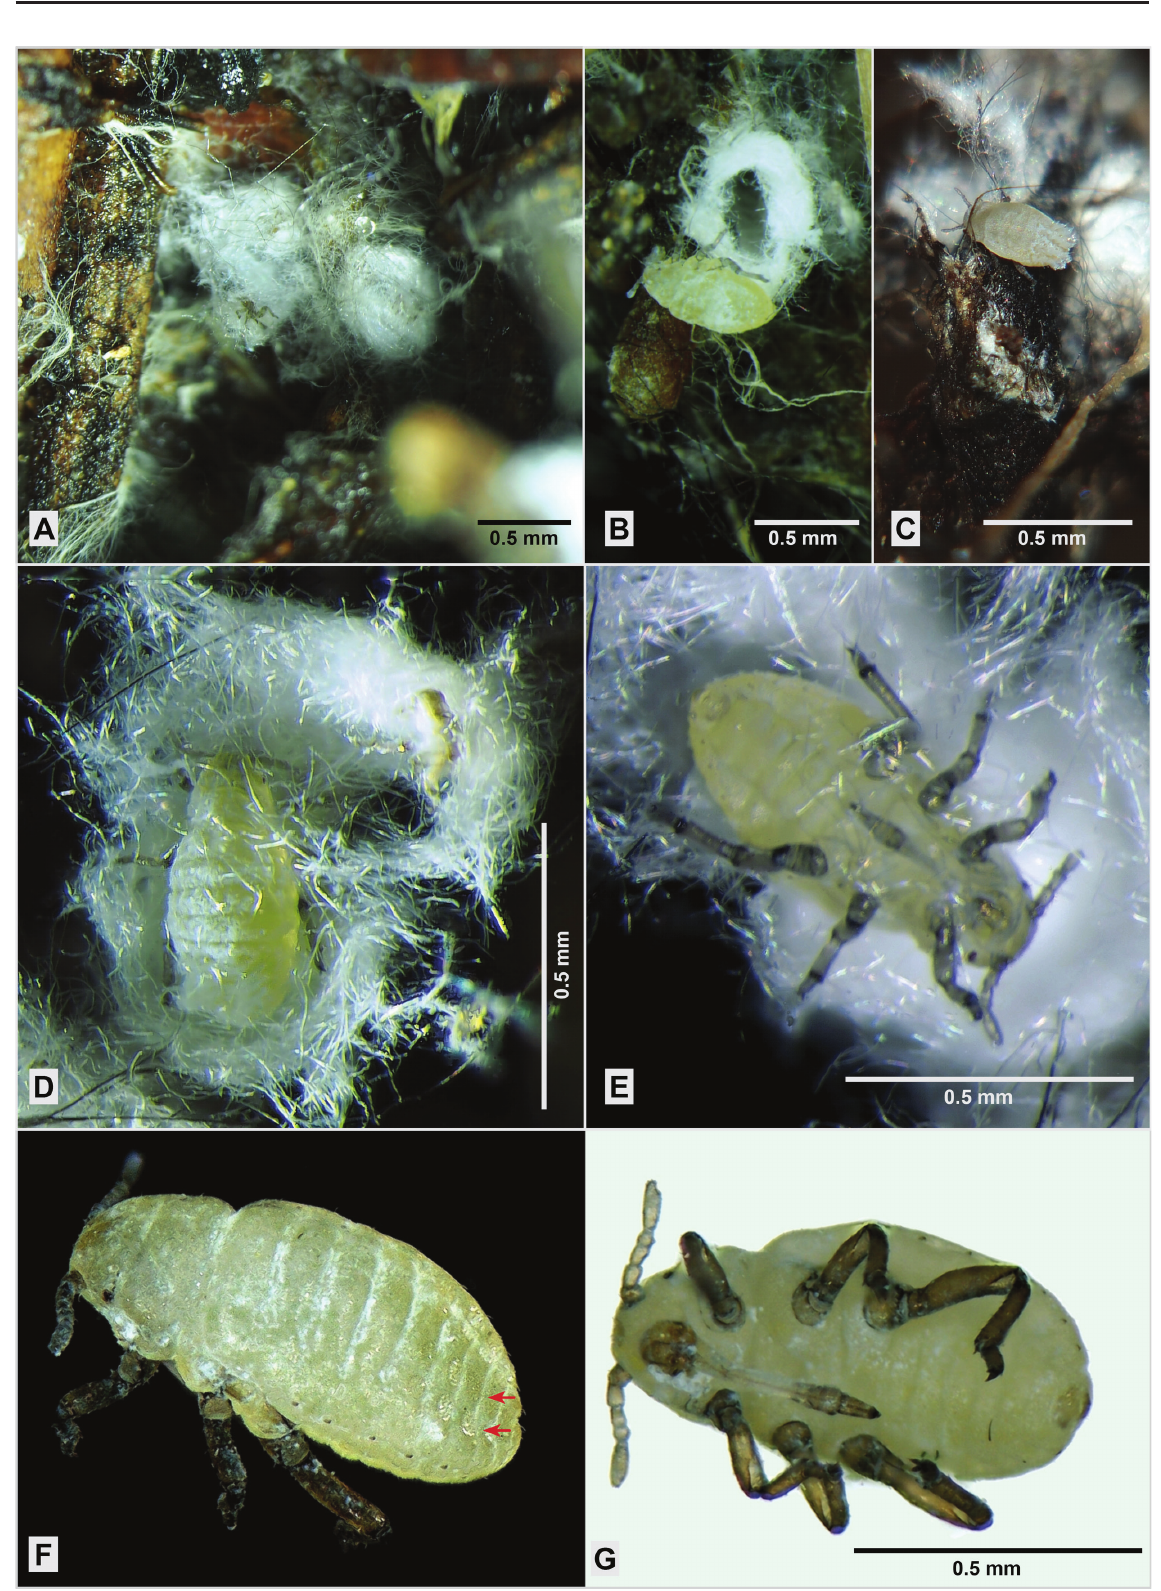
Fig. 18. Pachypappella lactea (tullgren, 1909). A–E . Apt. and wax cells on terminal Picea abies roots. F–G . Apt. from Hylocomium splendens sample. two wax gland plates in F indicated by